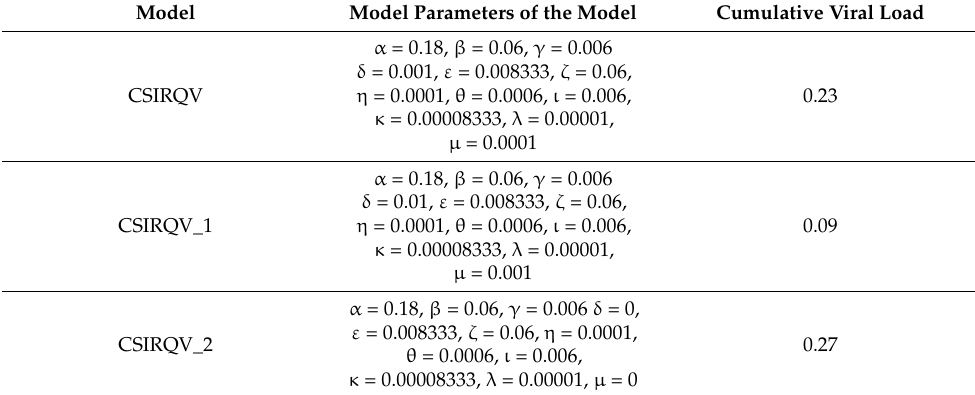
Table 3. Viral Load estimations for different scenarios of the CSIRQV model (t = 365 days).